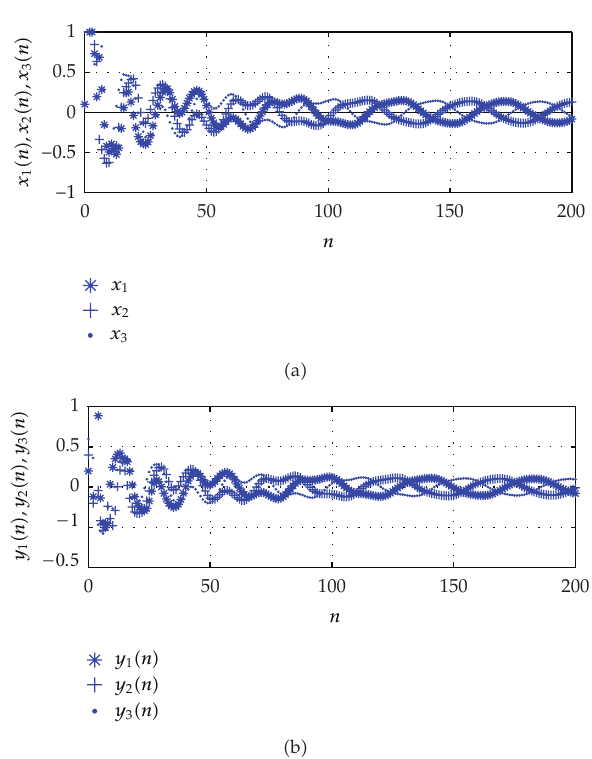
Figure 2: Two phase-locked oscillations: x 1 (cid:3) n (cid:4) (cid:8) x 2 (cid:3) n (cid:9) P T / 3 (cid:4) (cid:8) x 3 (cid:3) n (cid:9) 2 P T / 3 (cid:4) , y 1 (cid:3) n (cid:4) (cid:8) y 2 (cid:3) n (cid:9) P T / 3 (cid:4) (cid:8) y 3 (cid:3) n (cid:9) P T / 3 (cid:4)